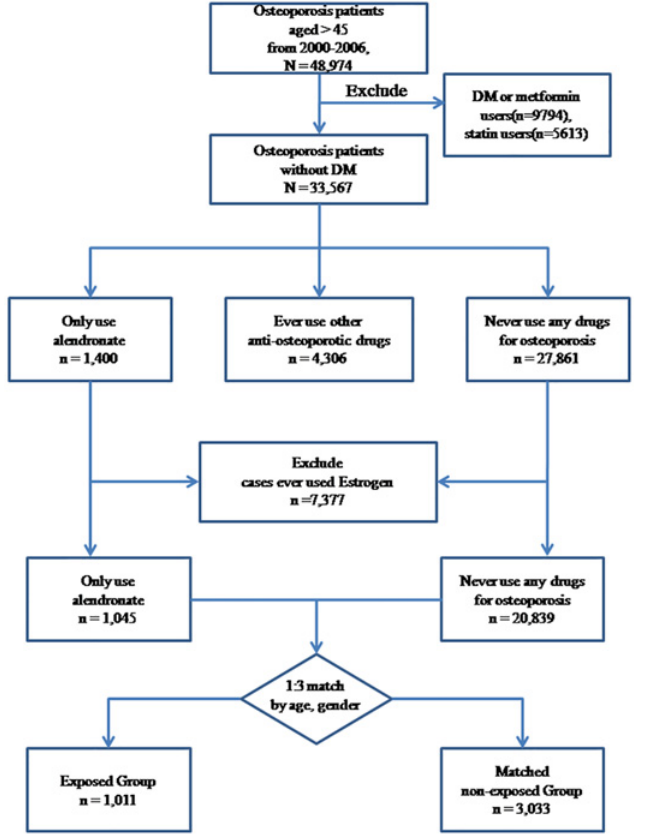
Fig 1. Flowchart of our